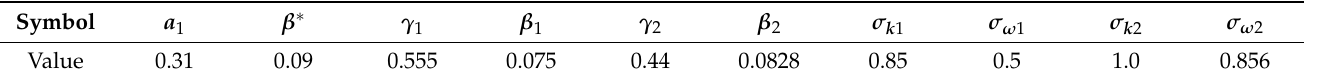
Table 1. Constants for the k − ω SST